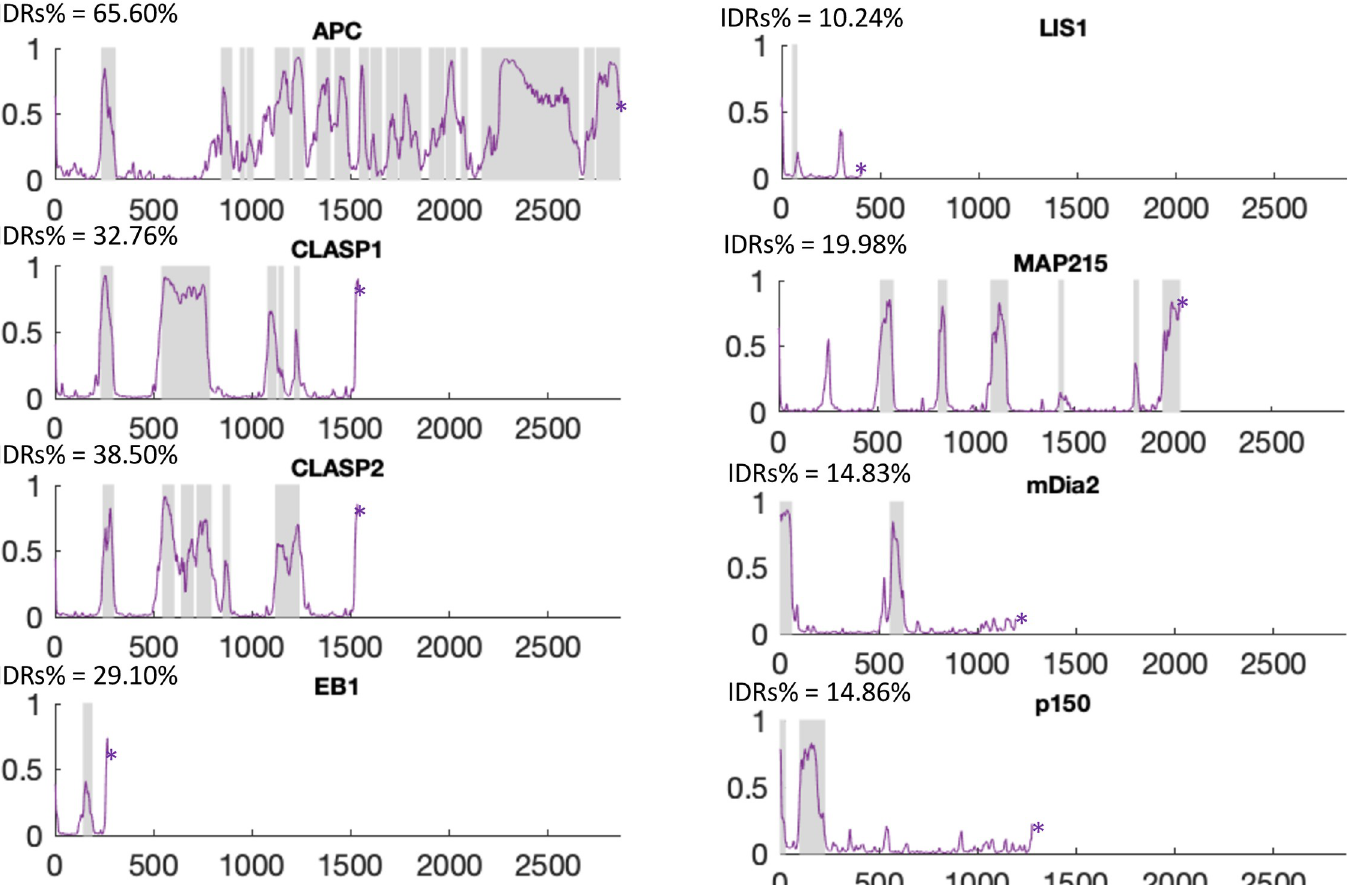
Fig 9. Analyses of IDRs in members of the human +TIP network. The Y-axis provides the probability of IDRs as a function of amino acid position (X-axis); 1 indicates 100% likelihood. The purple line provides the data for Espritz; shaded areas are the disordered regions predicted by MobiDB-lite. See Materials and Methods for the accession